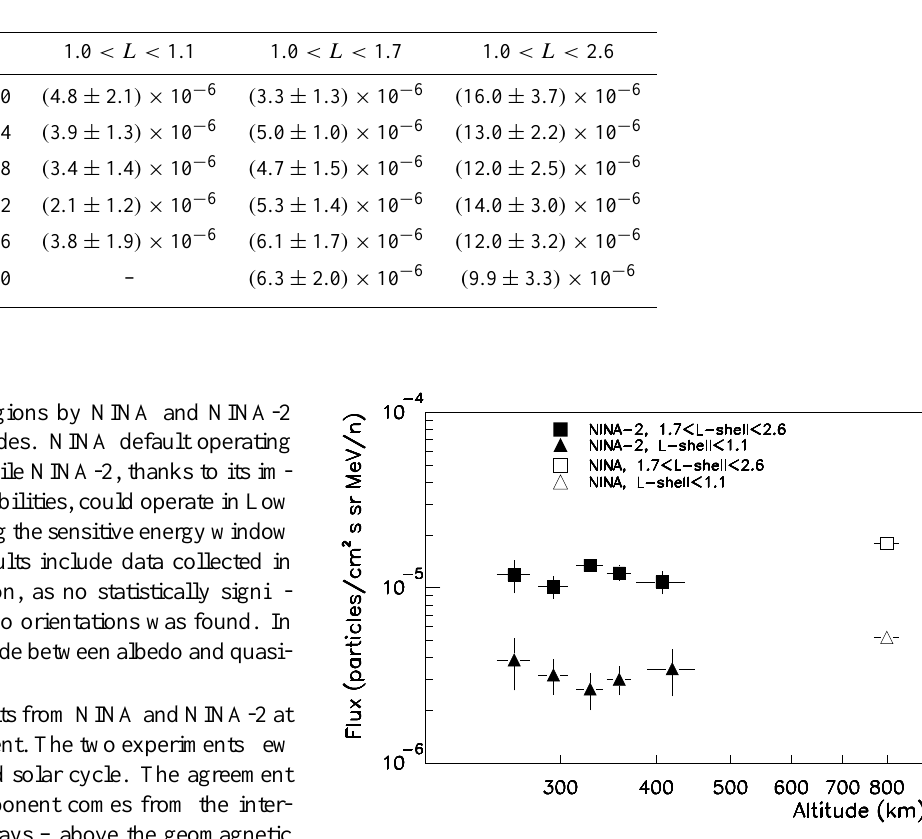
Table 1. Table of proton fluxes (in particles/cm 2 ssrMeV/n) measured by NINA-2 as a function of energy (rows, in MeV) in different L-shell intervals (columns)